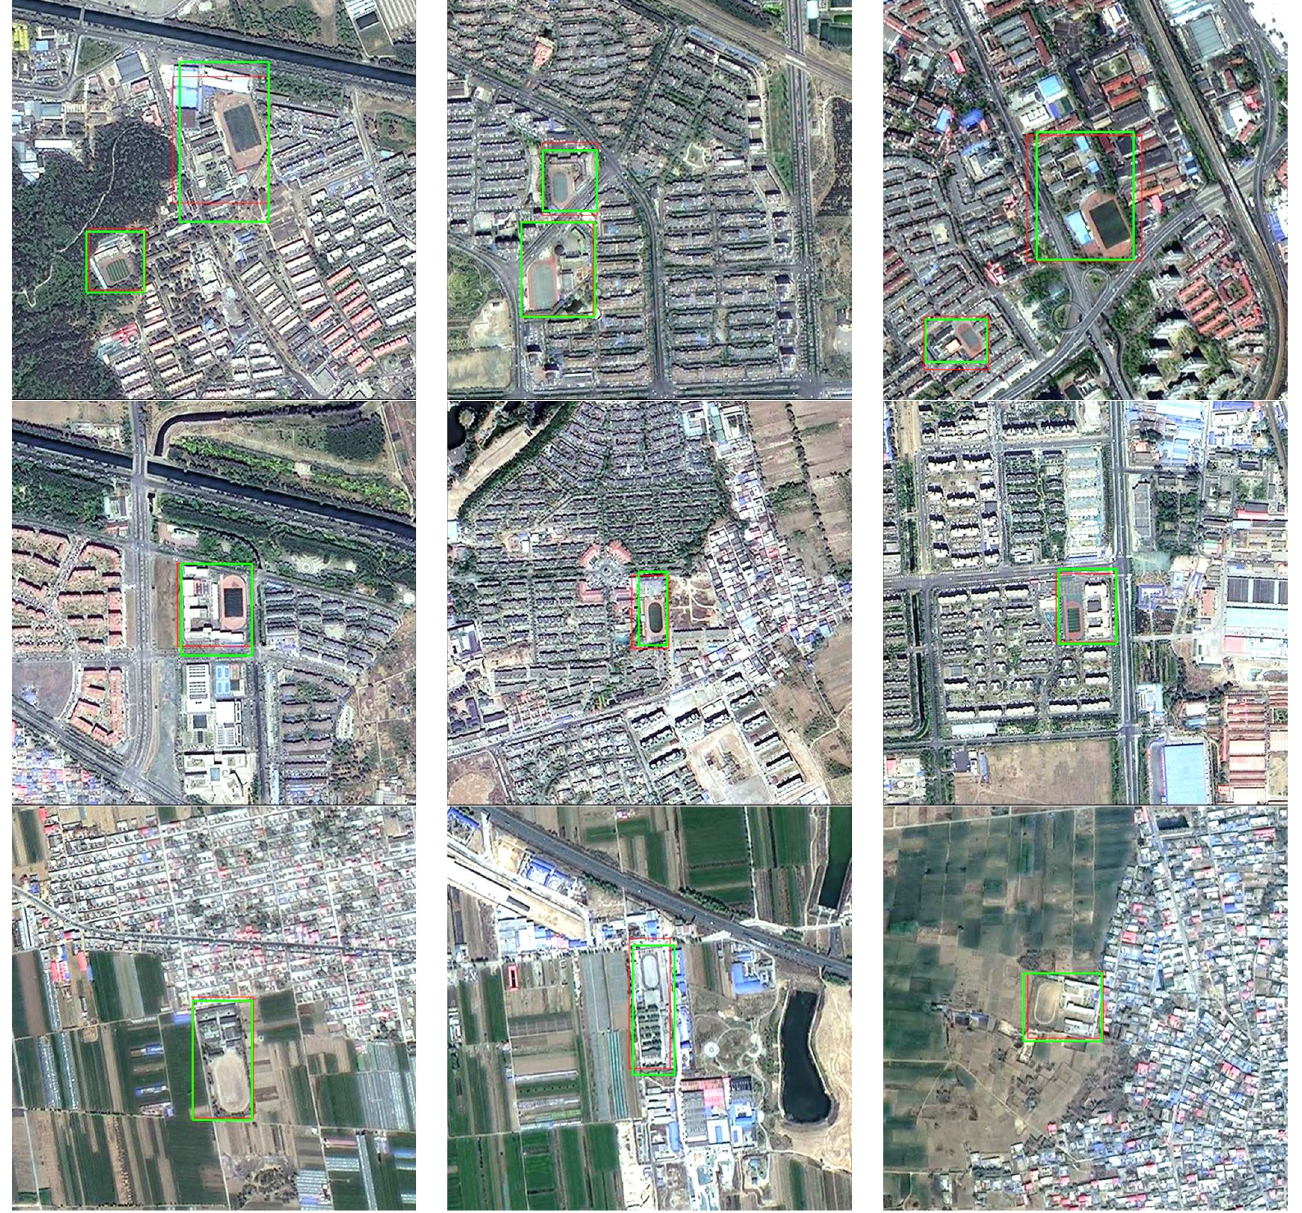
Figure 11. Results of ADNet on the test set. The ground truth boxes are plotted in green, and the detection results of ADNet are plotted in red .